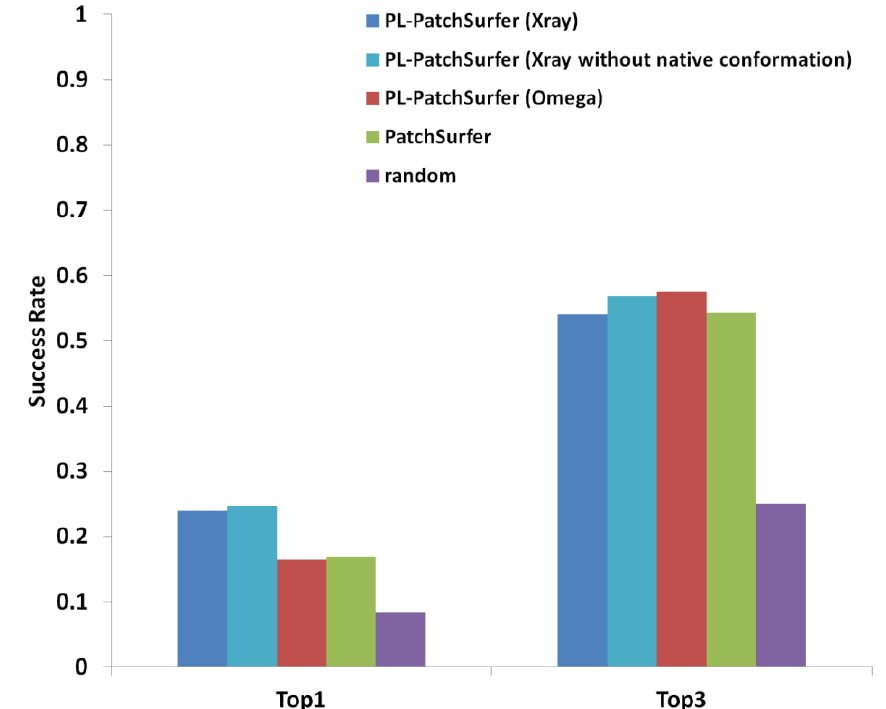
Figure 1. Performance of PL-PatchSurfer and PatchSurfer on the Huang data set. For PL-PatchSurfer, three tests were performed: (i) X-ray: the bound ligand conformations of all the tested proteins are extracted to form the “X-ray ligand conformation database”; (ii) X-ray without native conformation: the native ligand conformation of the query pocket was removed from the “X-ray ligand conformation database”; and (iii) Omega: A maximum of 20 ligand conformations with the lowest internal energies are computationally generated by OpenEye Omega. The data for PatchSurfer was extracted from a previous publication